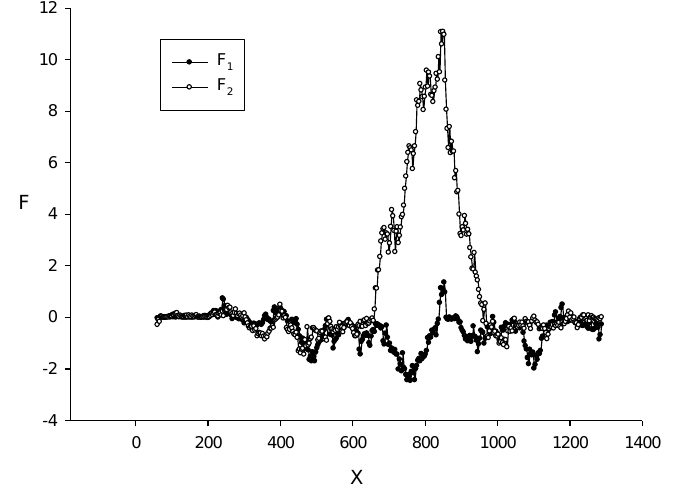
Fig.1. The functions F and F are shown against position x for the sequence BSU24300 from 1 2 Kegg data bank. This gene codes the amino acid sequence of the exodeoxyribonuclease VII large subunit from B.subtilis genome (Swiss-Prot entry is EX7L_BACSU).